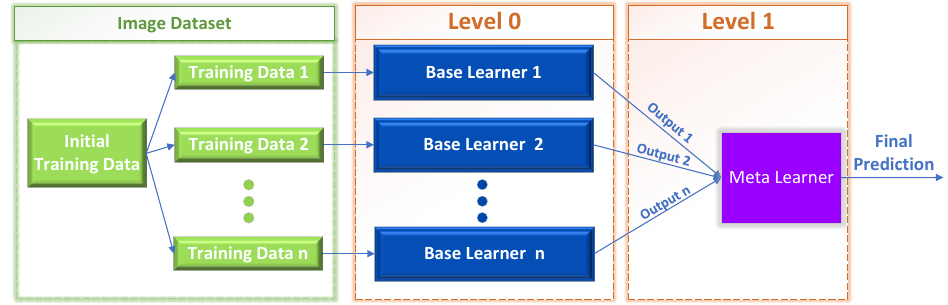
Figure 2. Stacked generalization